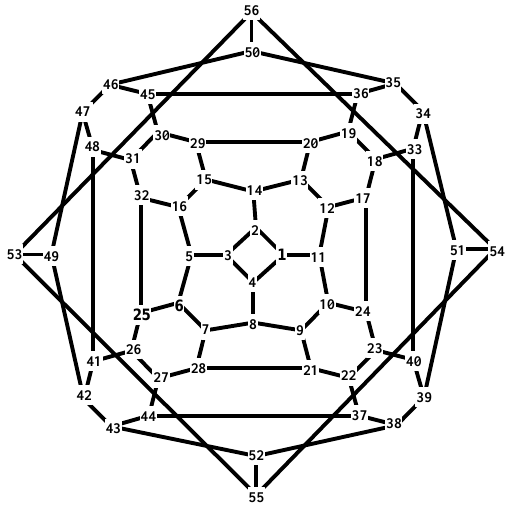
Figure 3. Labeling of the polyhedral graph